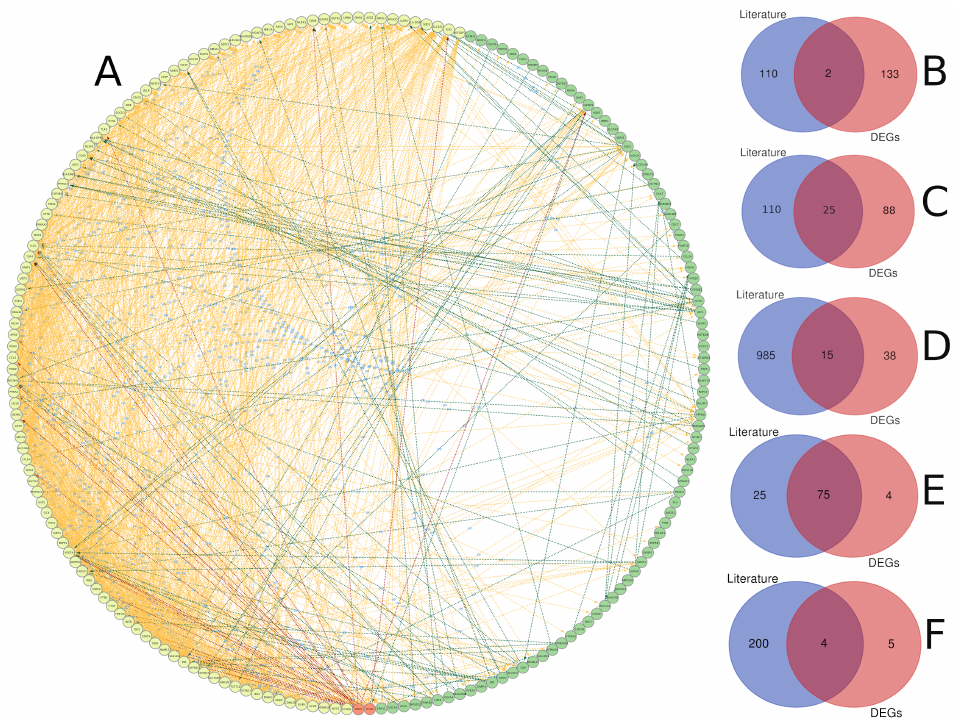
Figure 9. A comparison of genes linked to diabetes detected through gene expression and text mining. ( A ) Protein–protein interaction between diabetes-related genes identified through text mining (yellow), gene expression (green), or both (red), with the interaction link coloured according to the group of the interaction-source gene. The intersection of gene lists based on gene name ( B ), chromosomal location (genes with inter-space region less than 1 Mbp) ( C ), biological pathway ( D ), gene ontology ( E ), and KEGG pathway ( F )